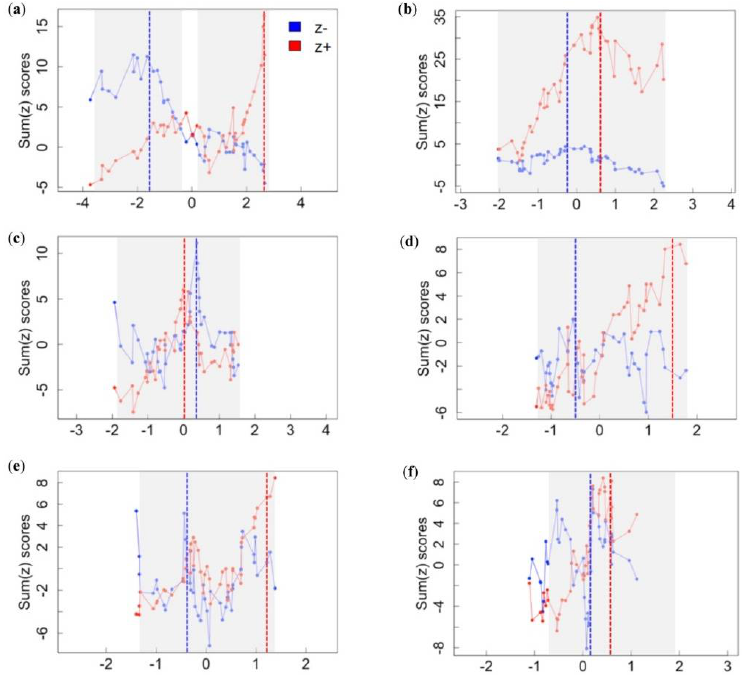
Figure 2. Ecological thresholds identified for cave-roosting bat assemblages along environmental and human disturbance gradients. Connected circles represent the summed z-scores for all species in the negative (blue) and positive (red) response groups at each candidate change-point along gradients: ( a ) landscape disturbance, ( b ) cave complexity, ( c ) mining, ( d ) cave development, ( e ) resource extraction, and ( f ) bat hunting. The largest sum(z) score for each response group result from congruent responses among species at a similar change-point, which defines the assemblage-level threshold along the gradient (vertical dashed lines with 95% confidence intervals in shading).